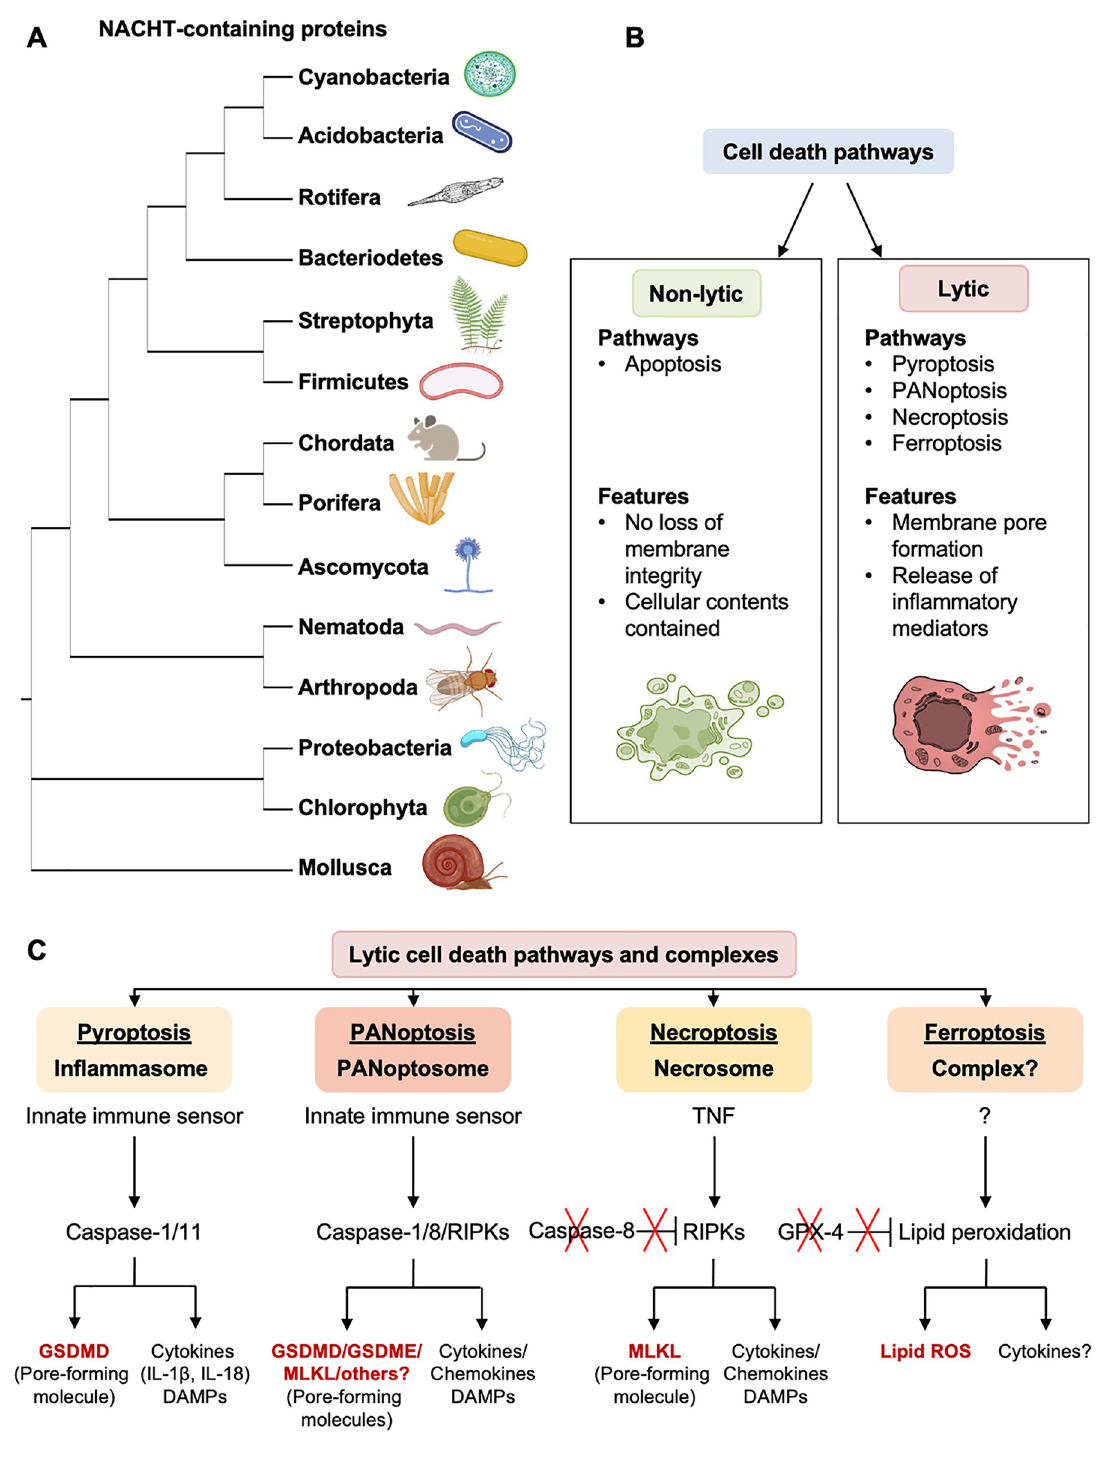
Fig 1. Evolutionary conservation of the innate immune pattern recognition receptor NLR family and the induction of III-RCD pathways. (A) Phylogenetic tree of NACHT domain-containing proteins, including the NLR family of pattern recognition receptors, from select bacterial and eukaryotic phyla. The tree was built using IQTREE2 phylogenetic software with protein sequences from Mollusca ( Candidula unifasciata ), Proteobacteria ( Pseudomonas fluorescens ), Nematoda ( Caenorhabditis elegans ), Arthropoda ( Drosophila melanogaster ), Chlorophyta ( Chlamydomonas reinhardtii ), Ascomycota ( Aspergillus niger ), Streptophyta ( Selaginella